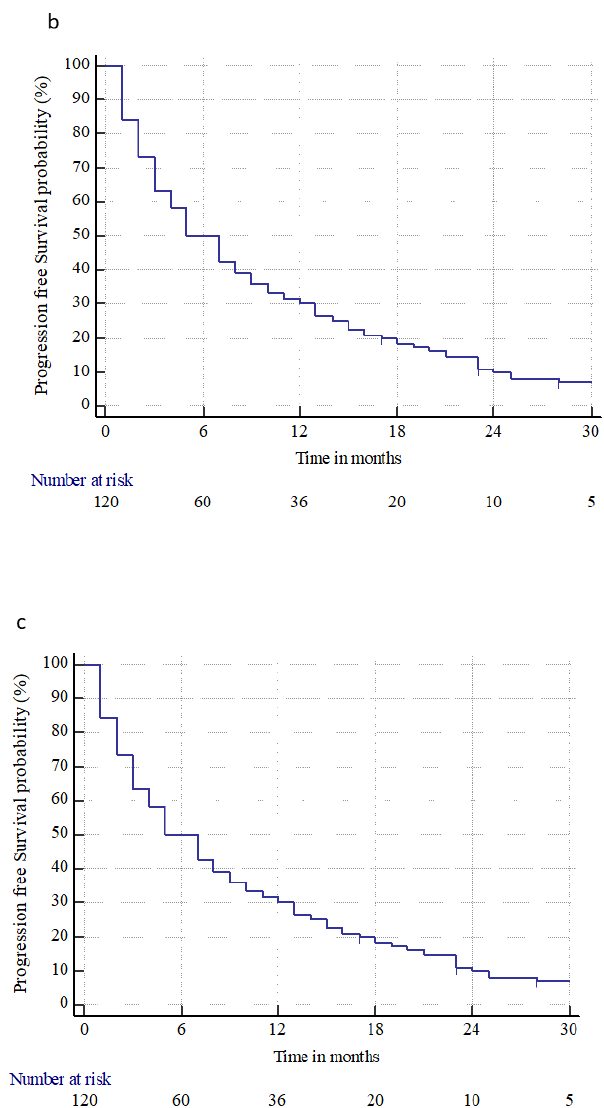
Figure 2. Brain distant failure ( a ), progression-free survival ( b ), and overall survival ( c ) from brain metastasis treatments (radiosurgery or surgery followed by radiosurgery), in patients with primary renal cell carcinoma.